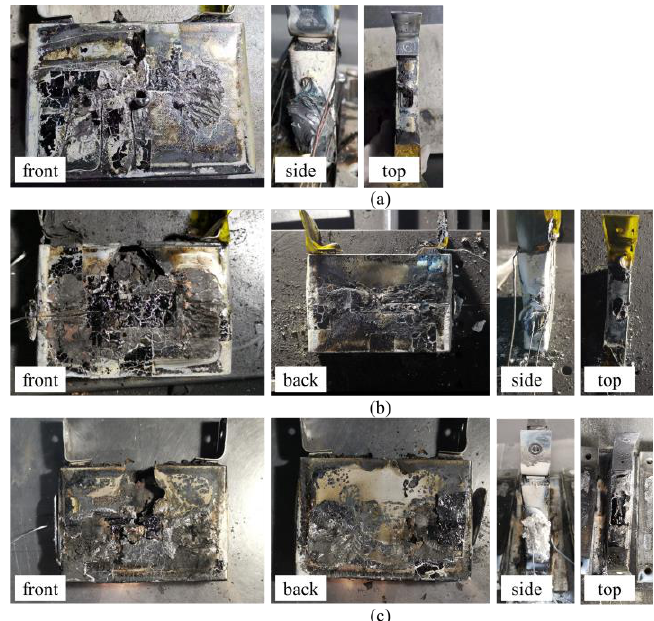
Figure 11. Cell wreckage after different abuse test. ( a ) Nail penetration; ( b ) Side heating; ( c ) Over- charge.